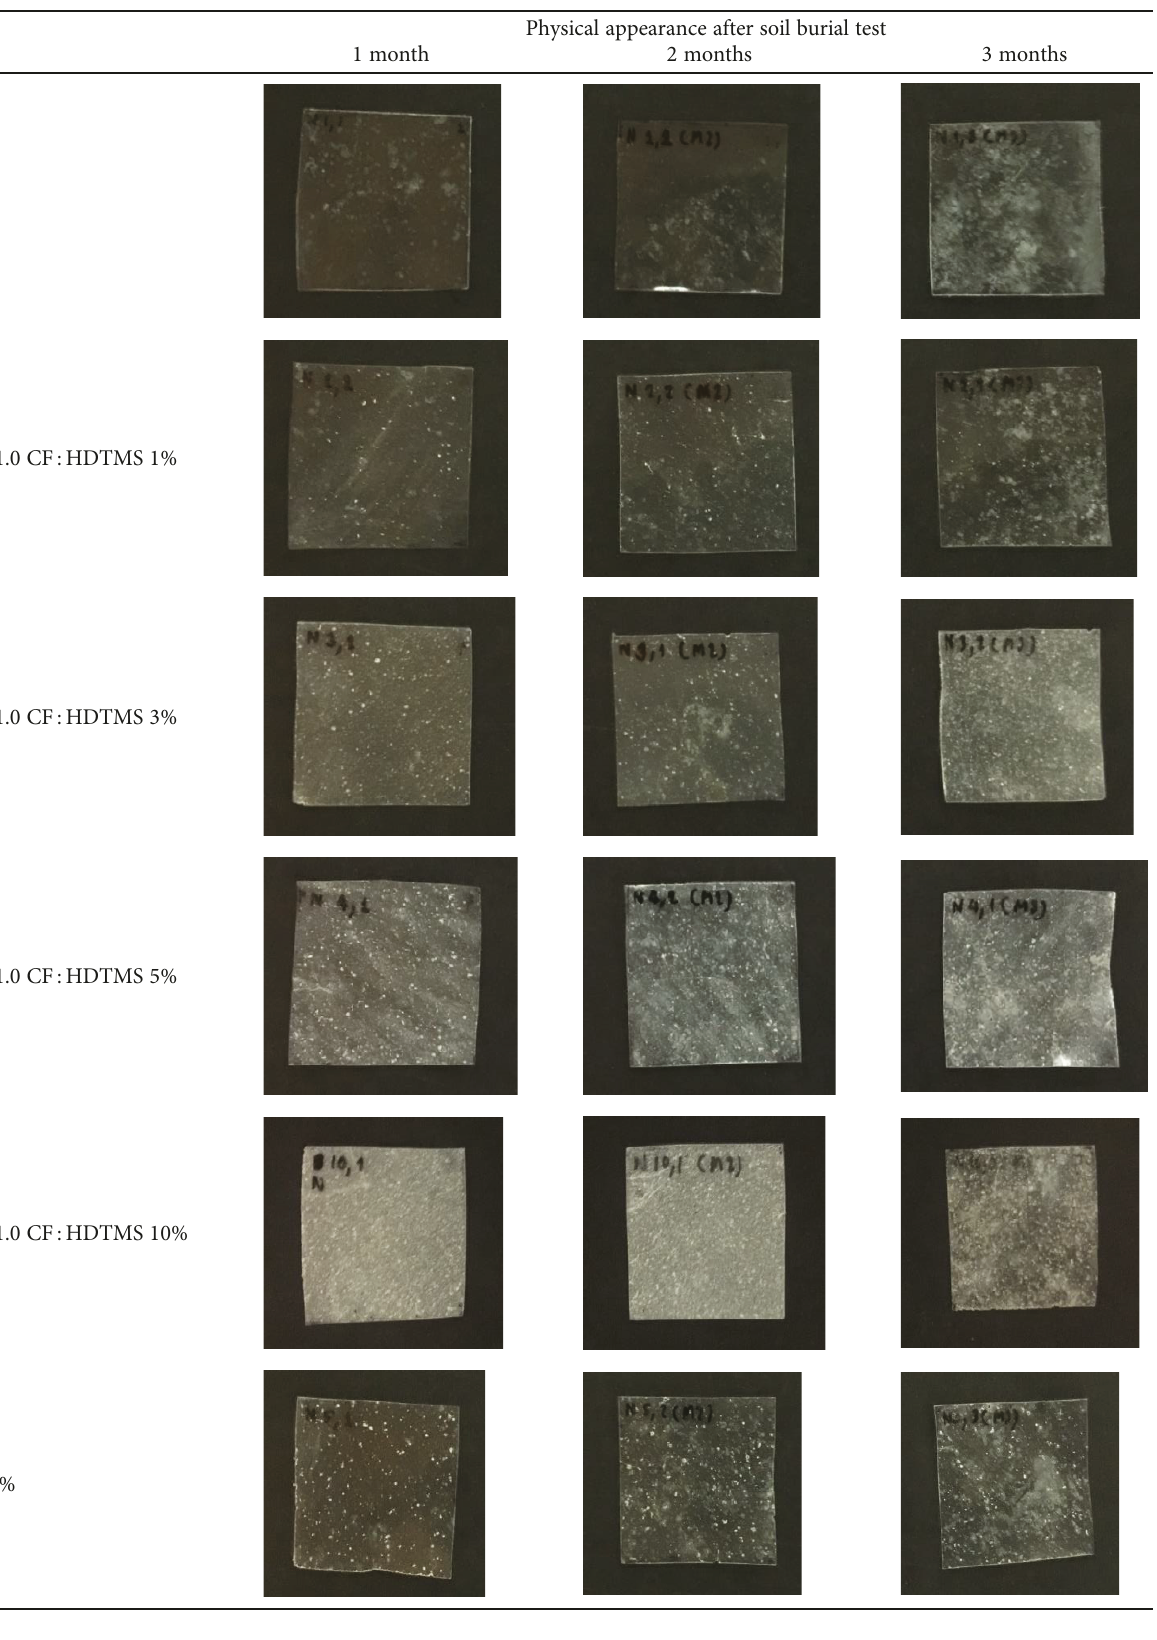
Table 3: Physical appearance after soil burial